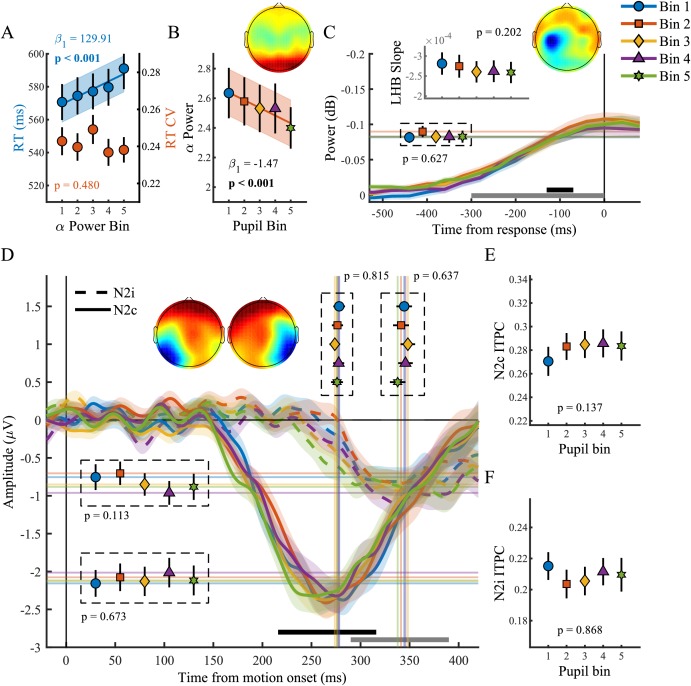
The phasic pupil response in relation to EEG signatures of attentional engagement, motor response and early target selection.(A) RT and RTcv in relation to pre-target α power. (B) Pre-target α power in relation to the pupil response. (C) Response-related left hemispheric β power (LHB) per pupil bin. Horizontal lines and markers indicate the average LHB in the time window indicated by the black bar. Inset shows LHB build-up rate, as determined by fitting a straight line through the LHB in the time window indicated by the grey bar. Note the reverse y-axis direction. (D) The stimulus-locked N2c (solid lines) and N2i (dashed lines) time-course binned by the pupil response. Vertical lines and markers show the peak latencies. Horizontal lines and markers show the average N2 amplitude during the time period indicated by the black (N2c) and grey (N2i) bars. (E–F) N2c (E) and N2i (F) ITPC per pupil bin over the time and frequency window determined based on the grand average ITPC (Figure 3—figure supplement 1). Insets show the scalp topography of each neural signal. Error bars and shaded regions denote ±1 SEM. Stats, linear mixed effects model analyses (Statistical analyses). Lines and shading indicate significant fits to the data.10.7554/eLife.42541.017Figure 3—source data 1.Csv table containing data for Figure 3 panel A.10.7554/eLife.42541.018Figure 3—source data 2.Csv table containing data for Figure 3 panel B-F.